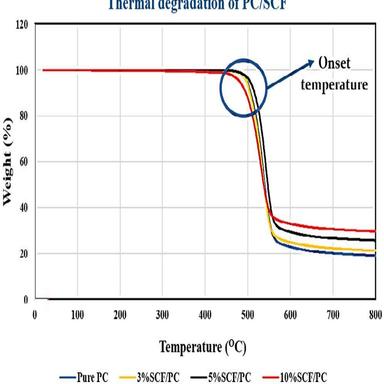
Plot showing the thermal degradation of SCF/PC composite material for different fiber concentration.